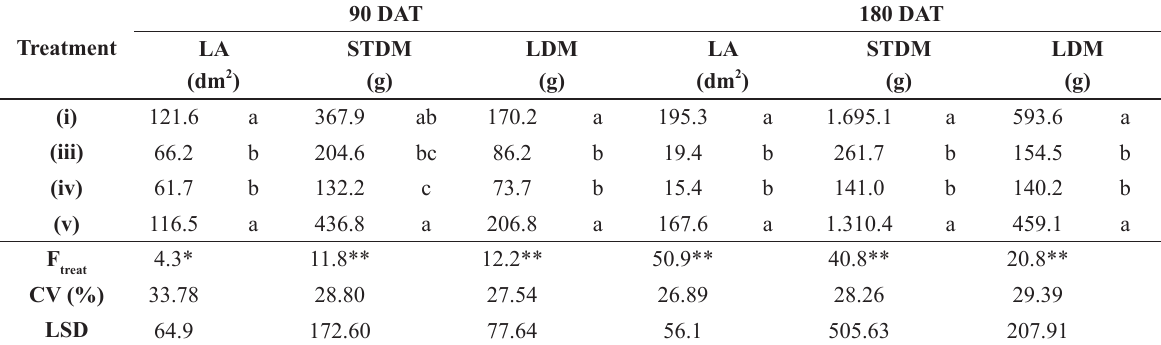
Leaf area (LA) and leaf (LDM) and stalk (STDM) dry matter of sugarcane plants under different intercropping conditions with morning glory plants evaluated at 90 and 180 days after transplantation